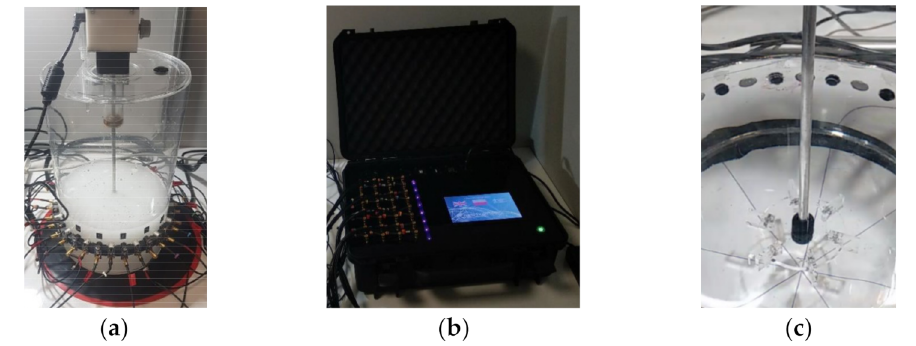
Figure 4. Ultrasound experimental setup. ( a ) Reactor tank, ( b ) measurement unit, ( c )